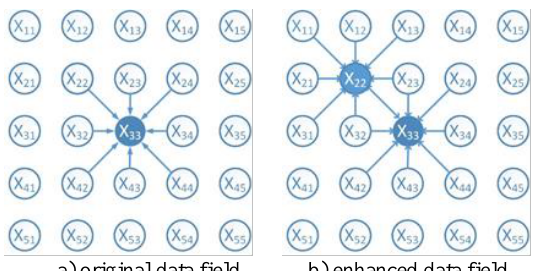
Figure 1 Figure different description ways of the original data